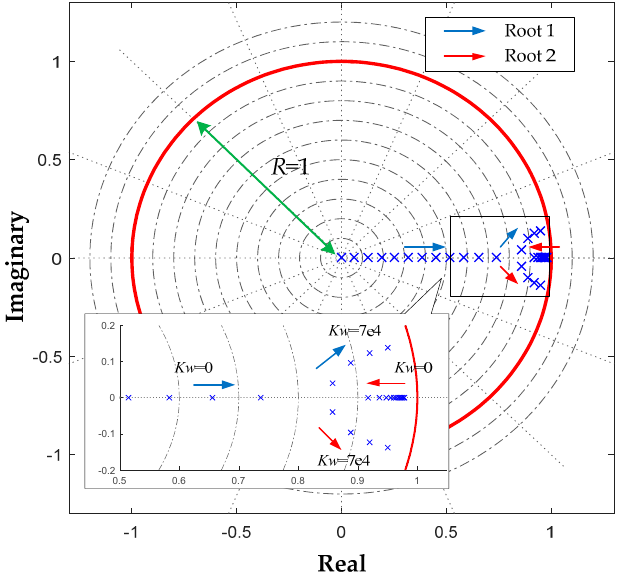
Figure 9. Eigenvalue locus of proposed control system.